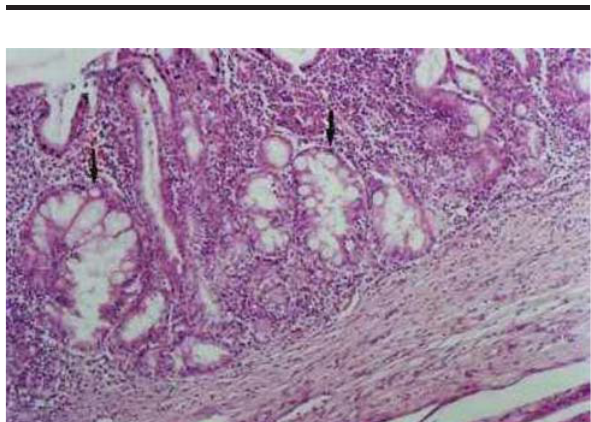
FIGURA 16 - Fotografia mostra a peça operatória aberta longitudinalmente. Colédoco dilatado (C), anastomose ampla (A) e duodeno (D). Suíno 9. Grupo I.